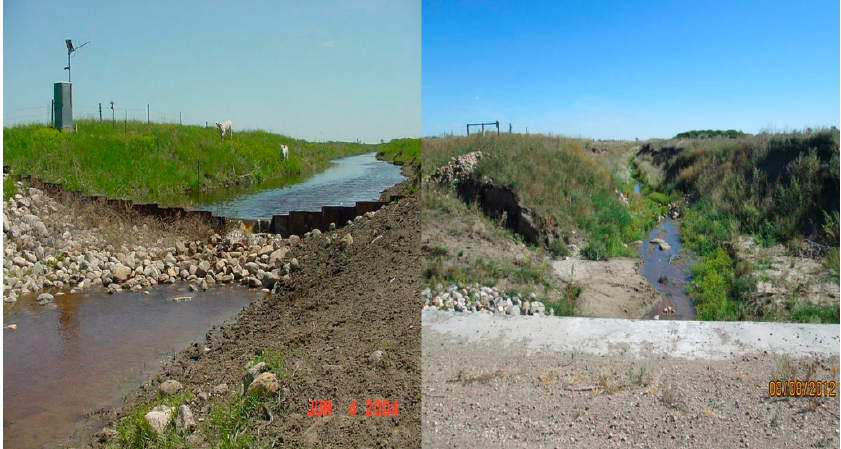
Figure 5. Rock and sheet pile weir (installed in 2001) at the Road 1212 crossing in June 2004 (photo from B. Braun, U.S. Forest Service) and at the same location in August 2012 (photo from P. Gerla).